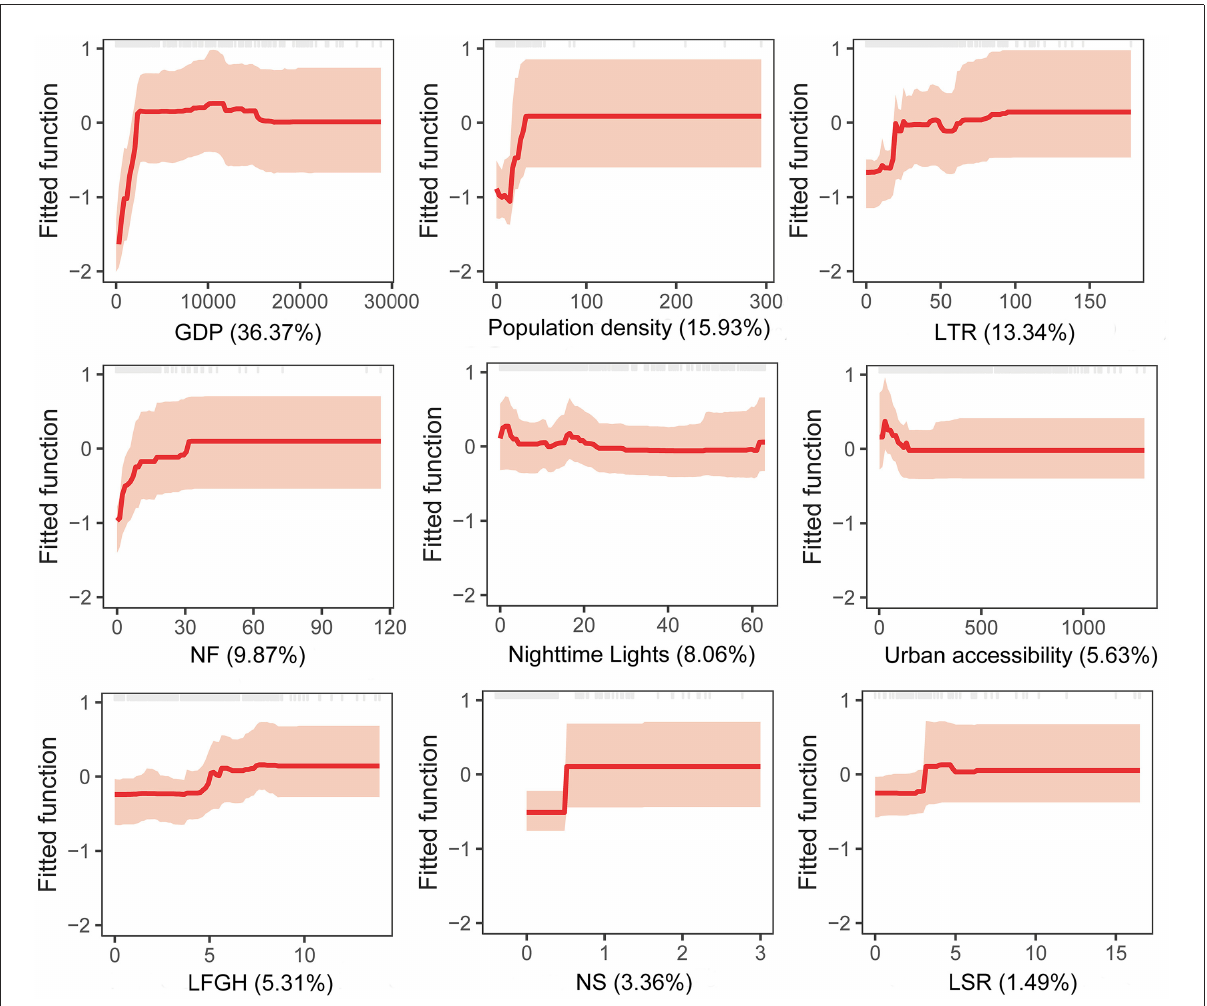
FIGURE4 Partial dependency plots with 95% confidence intervals for nine variables. The graphs show the effect of a given predictor on the probability of occurrence of human brucellosis, while keeping all other variables at their mean. Average relative influence of each predictor is reported between parentheses. Gray tick marks across the top of each plot indicate observed data points. GDP, gross domestic product; LTR, length of township roads; NF, number of farms; LFGH, length of first-grade highways; NS, number of slaughterhouses; LSR, length of secondary